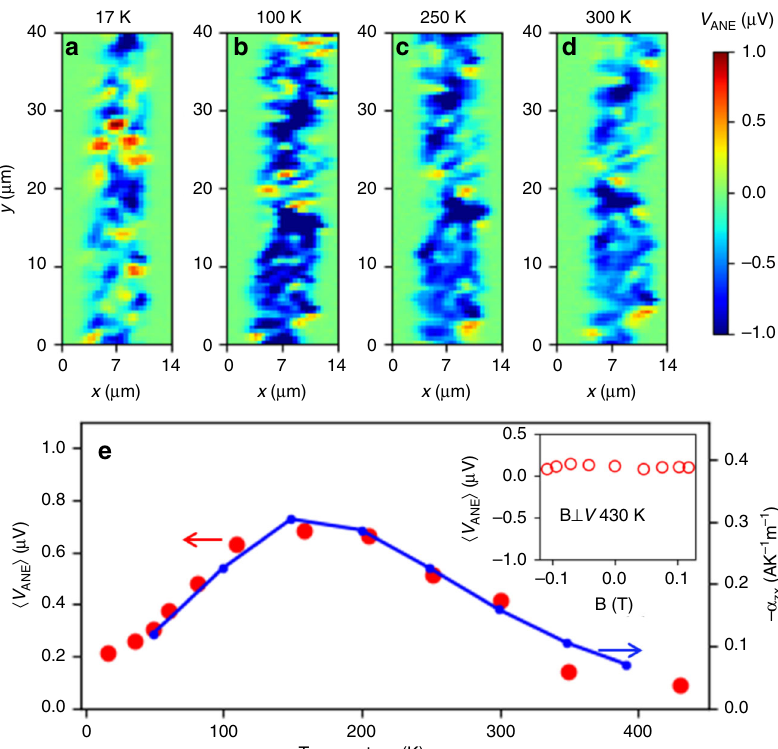
Fig. 3 Temperature dependency of the measured signal. V ANE changes with the sample temperature, as evident from the STGM maps at 17 K ( a ), 100 K ( b ), 250K ( c ), and 300 K ( d ). All scans were taken with a laser power of 10 mW. e The average h V temperature dependence as the anomalous Nernst effect reported in the bulk (blue line, data reproduced from ref. 4 ). Inset: Averaged voltage h V function of external magnetic fi eld (equivalent to the experiment in Fig. 2e) at 430 K (above the Néel temperature of Mn 3